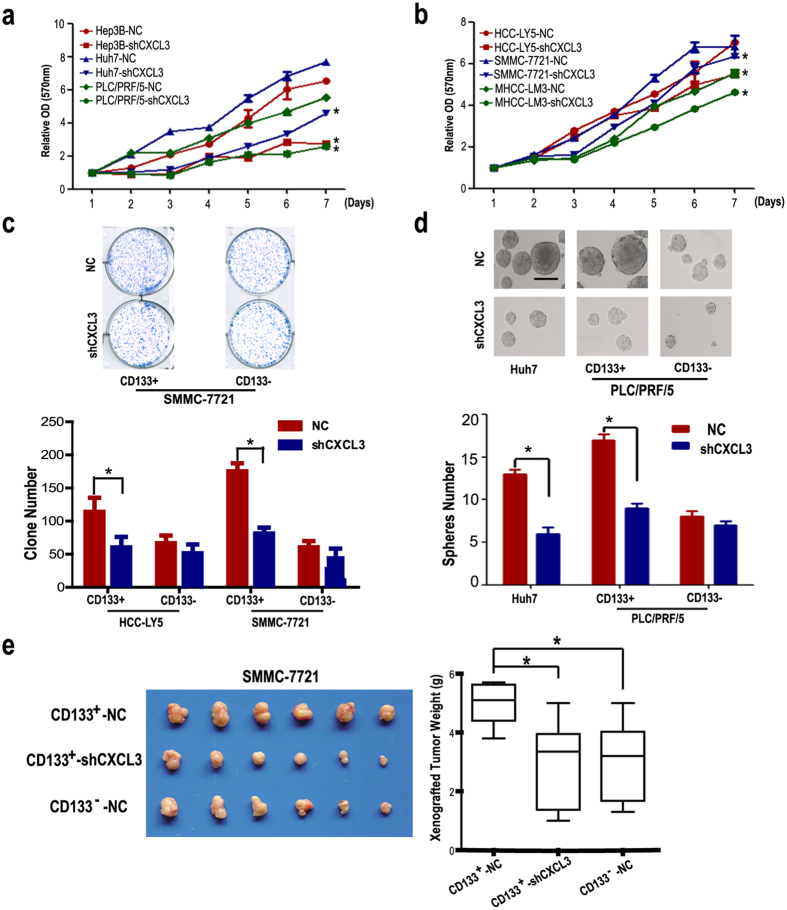
Down-regulation of CXCL3 expression inhibited HCC cells growth.(a) MTT assays showed that down-regulation of CXCL3 expression by shRNA inhibited cell growth in Hep3B, Huh7 and PLC/PRF/5 cells after day 4 (values were represented as the mean ± SD; *p < 0.05 vs shNC control, the Bonferroni method was used for the multiple comparison). (b) Down-regulation of CXCL3 inhibited cell growth in HCC-LY5, SMMC-7721 and MHCC-LM3 cells after day 4 (values were represented as the mean ± SD; *p < 0.05 vs shNC control, the Bonferroni method was used for the multiple comparison). (c) Results of the clone-formation assay in CXCL3 knockdown CD133+/CD133− HCC cells sorted from HCC-LY5 (p = 0.0005) and SMMC-7721 (p = 0.028) (values were represented as the mean ± SD; *p < 0.05; t-test, vs cells treated with shNC). (d) Tumor-sphere formation analysis displayed that CXCL3-silence decreased the tumor-sphere number in Huh7 (p = 0.0325) and PLC/PRF/5 (p = 0.0491) CD133+ cells (values were represented as the mean ± SD; *p < 0.05; t-test, vs cells treated with shNC). (e) The weight of tumors from BALB/c (nu/nu) mice injected with CXCL3 knockdown or control SMMC-7721 cells are shown (CD133+-NC vs CD133−-NC, p = 0.045; CD133+-NC vs CD133+-shCXCL3, p = 0.037) (values were represented as the mean ± SD; *p < 0.05 vs cells treated with shNC, the Bonferroni method was used for the multiple comparison).